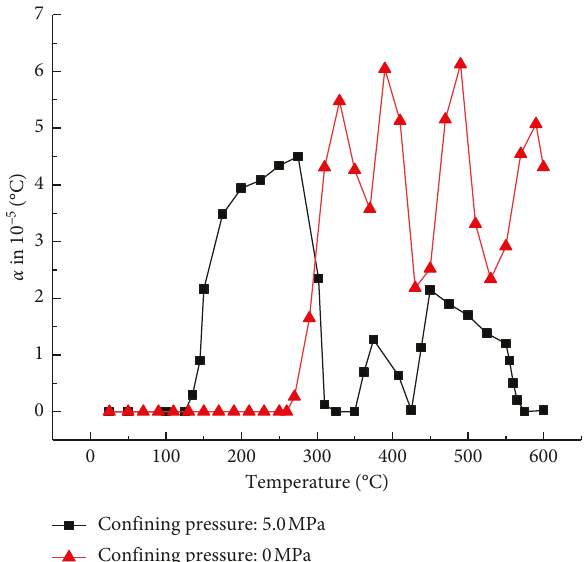
Figure 8: Thermal expansion coefficient ( α ) change versus tem- perature under different heating rates.